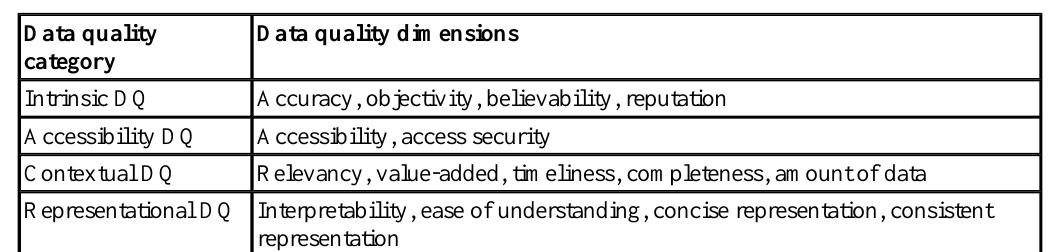
Table 2 Data quality categories and dimensions (Wang and Strong,